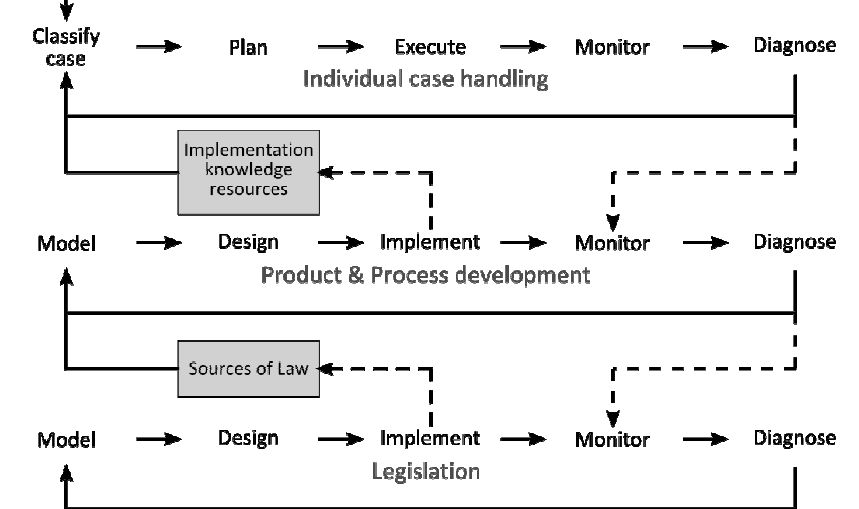
Figure 2: The case handling, development, and legislation problem solving